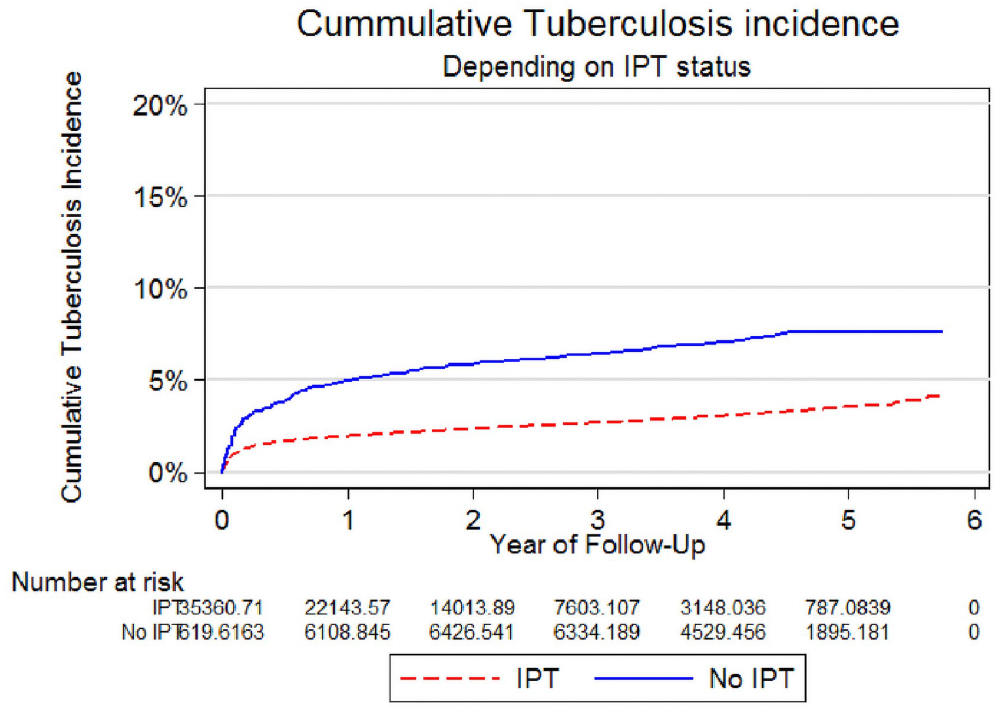
Fig 2. Kaplan Meier graph showing cumulative Tuberculosis incidence depending on the status of Isoniazid Preventive Therapy. Throughout the follow up, those who ever received IPT had less cumulative Tuberculosis incidence than those who did not receive the